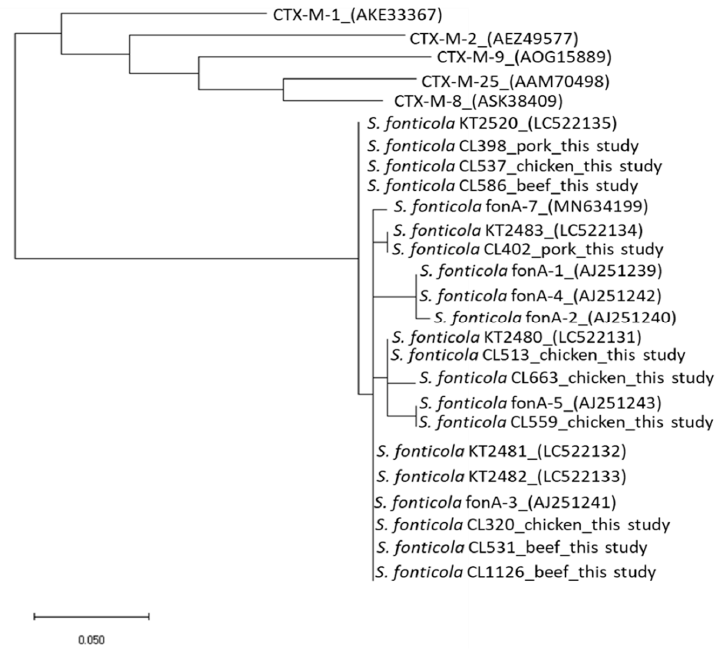
Figure 1. Phylogenetic comparison of the deduced amino sequences of the resistance gene bla fonA identified in Serratia fonticola isolated from chicken, pork, and beef purchased in Japan in this study with other sequences downloaded from GenBank. The relationship between bla fonA and CTX-M was also determined. The sources of the isolates identified in this study are indicated in the figure, and the GenBank accession numbers of the reference strains used are shown in